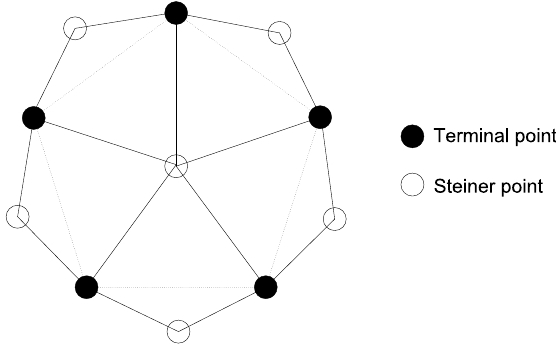
Figure 4. A tight example of Theorem